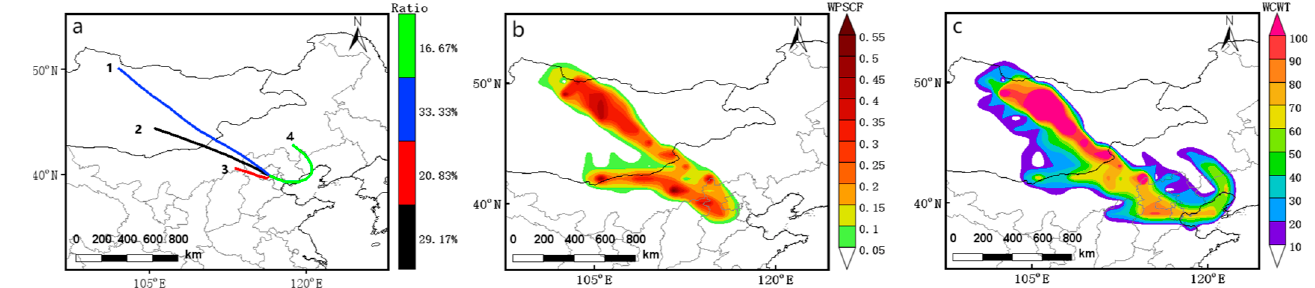
Figure 10. Spatial distribution of clusters by backward air mass trajectories, WPSCF, and WCWT (( a ) Backward air mass trajectories; ( b ) WPSCF; ( c ) WCWT).